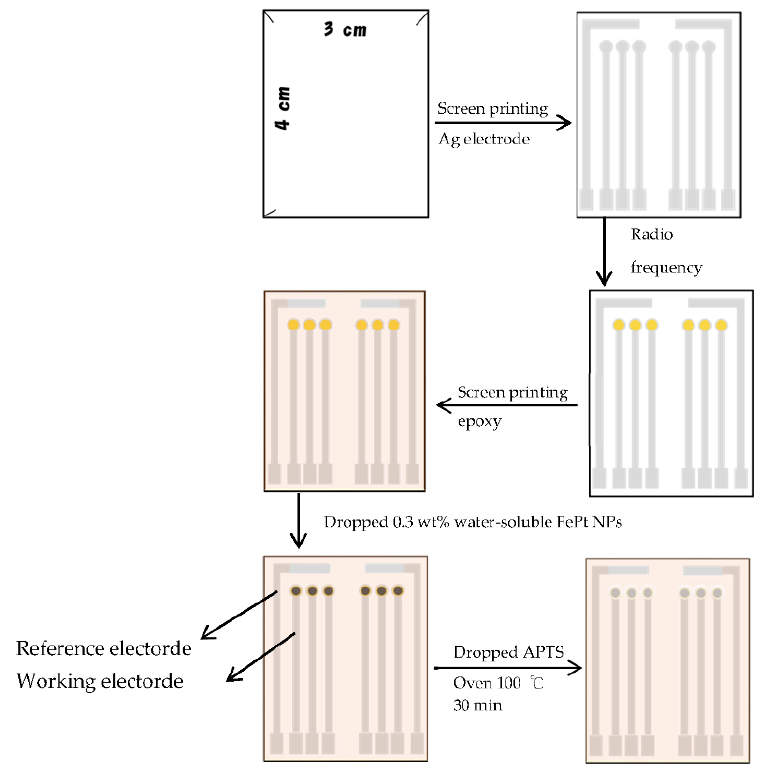
Figure 3. The diagram of the fabrication of the lactate biosensor.